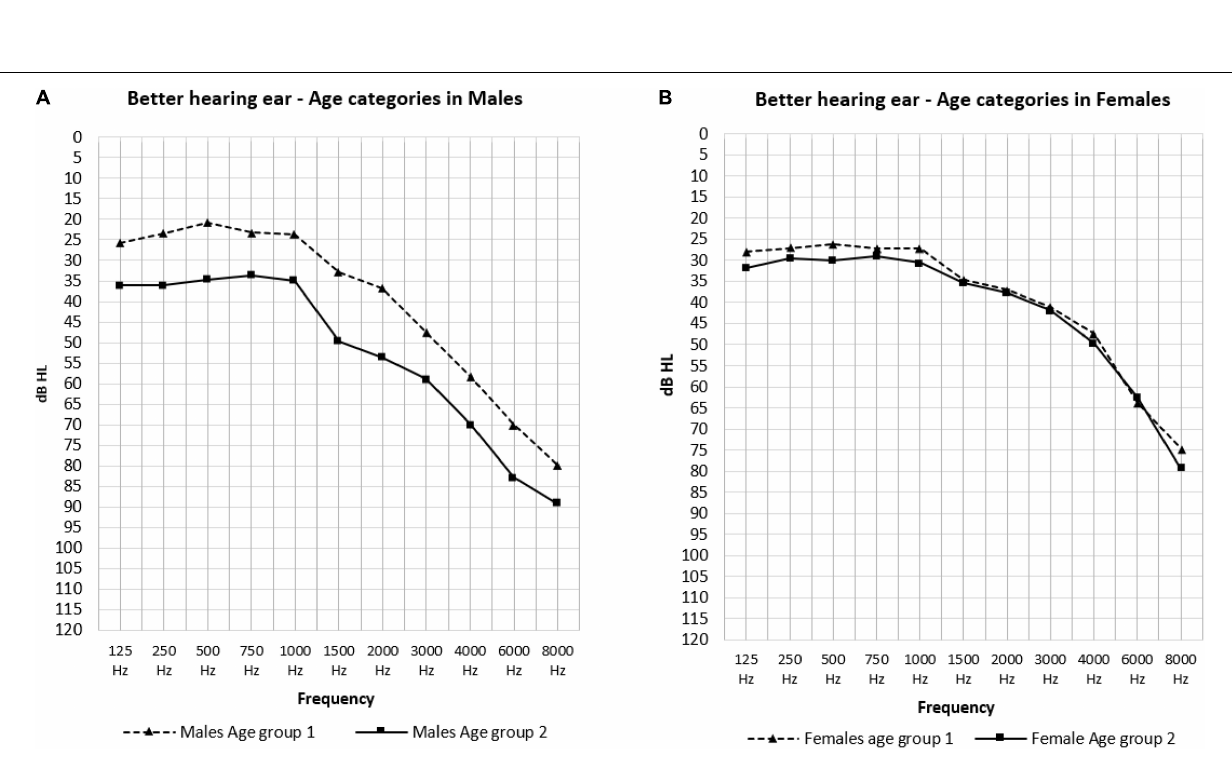
Frontiers in Psychology |